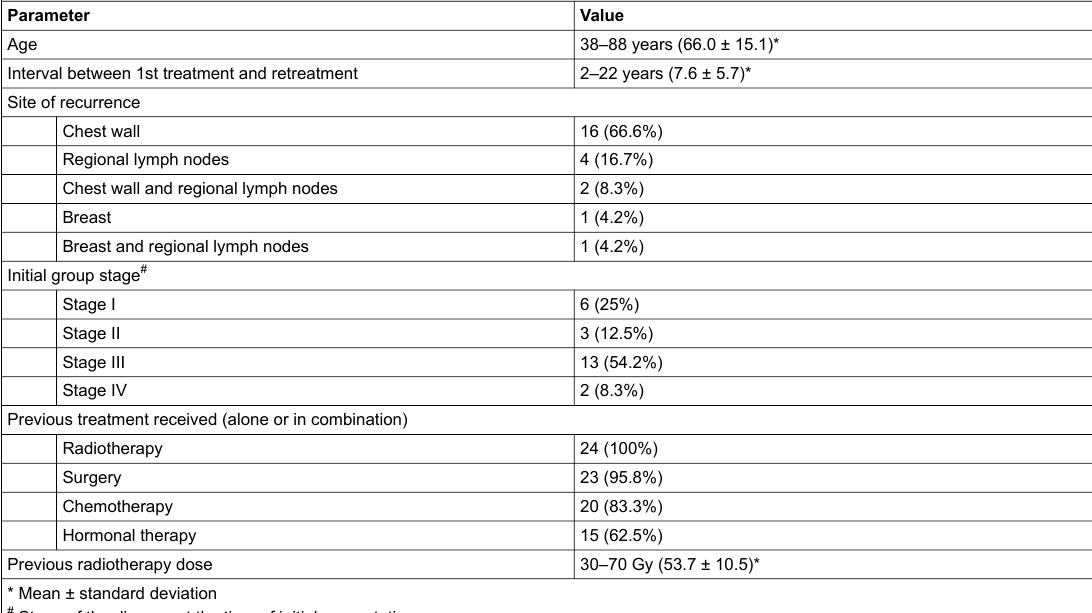
Table 1: Patient characteristics at the time of referral for reirradiation and